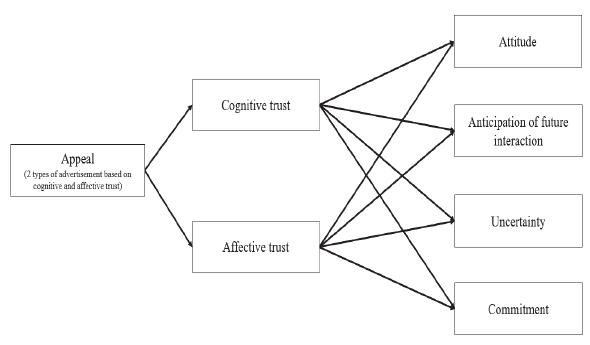
Fig. 1. Research model and